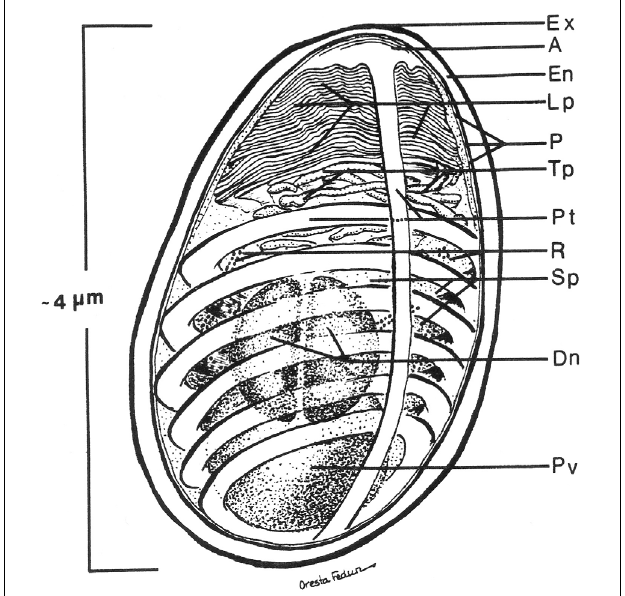
FIGURE 1 | Diagram of the internal structure of a microsporidian spore. The spore coat has an outer electron dense region called the exospore (Ex) and an inner thicker electron lucent region, endospore (En). A unit membrane (P) separates the spore coat from the spore contents. The extrusion apparatus, anchoring disc (A), polar tubule (Pt), lamellar polaroplast (lp), and tubular polaroplast (Tp) dominate the spore contents and is diagnostic for microsporidian identification. The posterior vacuole (Pv) is a membrane-bound vesicle that sometimes contains a “membrane whirl” or “glomerular like” structure or flocculent material or some combination of these structures. The spore cytoplasm is dense and contains ribosomes (R) in tightly coiled helical array. The nucleation may consist of a single nucleus or a pair of abutted nuclei, diplokaryon (D). The size of the spore depends on the particular species and can vary from less than one micron to over 10 microns. The number of polar tubule coils is also variable from a few to thirty or more, again depending on the species. Reprinted with the permission of the publisher (Cali and Takvorian, 2014).